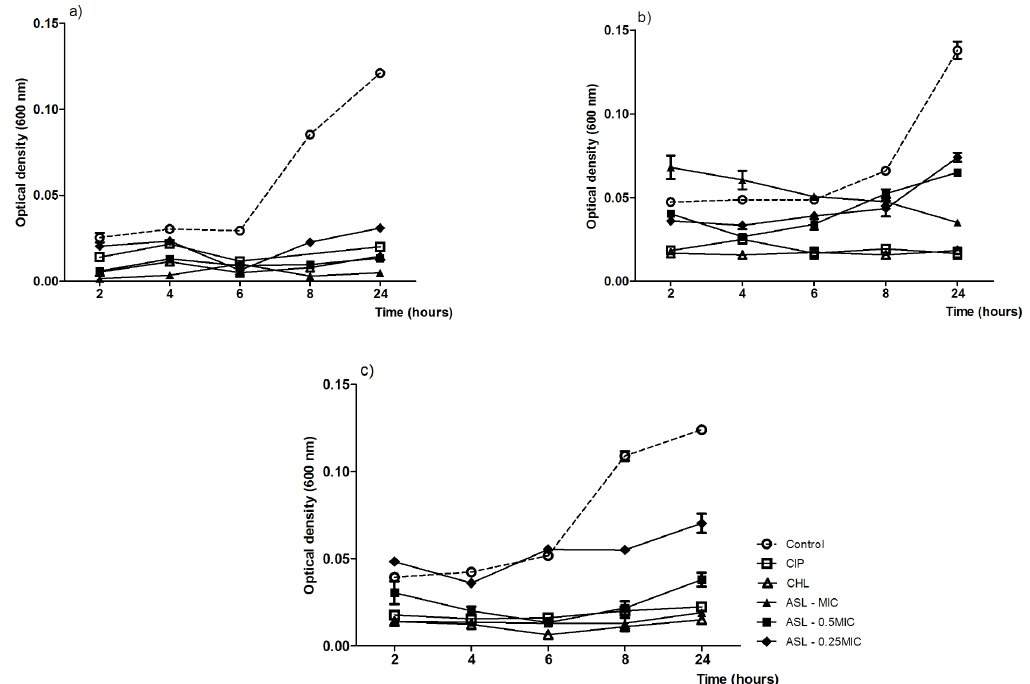
Figure 4 - Activity kinetics of methanolic extract of Annona squamosa leaves (ASL) against a ) S. aureus ; b ) K. pneumoniae and c ) E. faecalis . Choramphenicol (CHL) and ciprofloxacin (CIP) were used as positive controls. The experiments were carried out triplicate, and average values are reported. Error bars refer to the standard